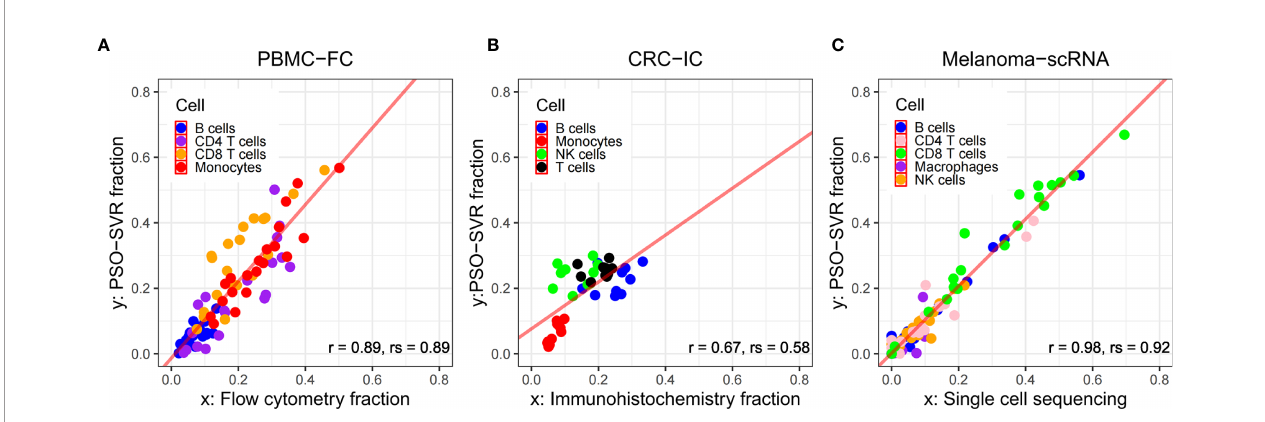
FIGURE 3 | Comparison between PSO-SVR and orthogonal technologies. Scatter plots of immune cell fractions with regression of (A) PBMC-FC; (B) CRC-IC; and (C) Melanoma-scRNA data; r for Pearson ’ s correlation, rs for Spearman ’